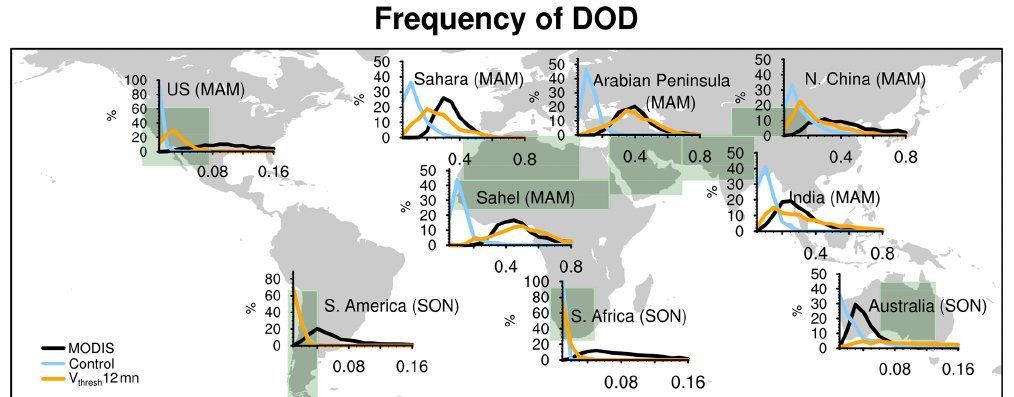
Figure 15. Frequency distribution (as a percentage) of regionally averaged daily DOD from MODIS (black) versus that from the Control (light blue) and V thresh 12mn (orange) simulations for the Sahara, the Sahel, the Arabian Peninsula, northern China, India, the western-to- central US, South America, South Africa, and Australia from 2003 to 2015. The x axis denotes the ranges of DOD (the bin spacing for dusty regions is 0.05 and for less dusty regions is 0.01), and the y axis is the percentage of occurrence. The light-green boxes denote the averaging areas. For regions in the Northern Hemisphere frequency in MAM is shown, while for regions in the Southern Hemisphere frequency in SON is